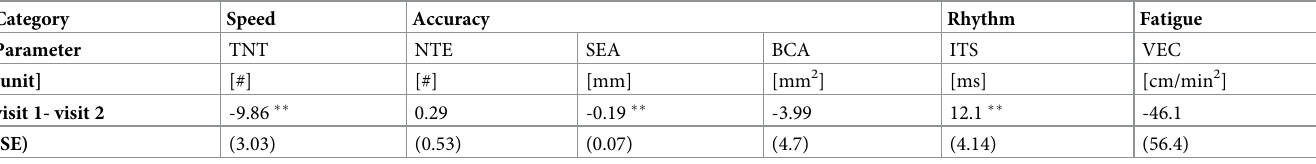
Table 7. Occasion effects on tapping